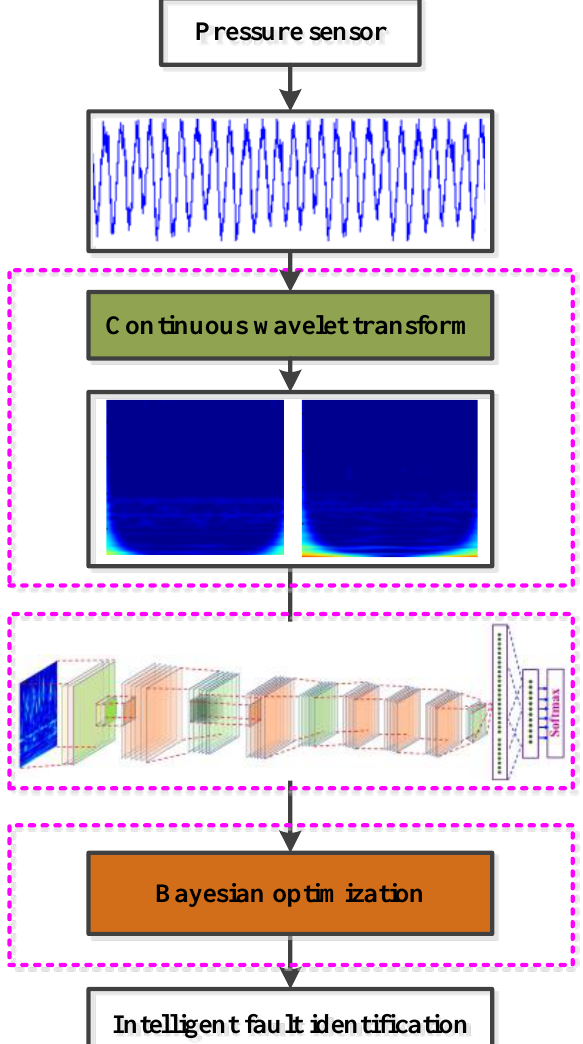
Figure 8. Proposed diagnosis method.